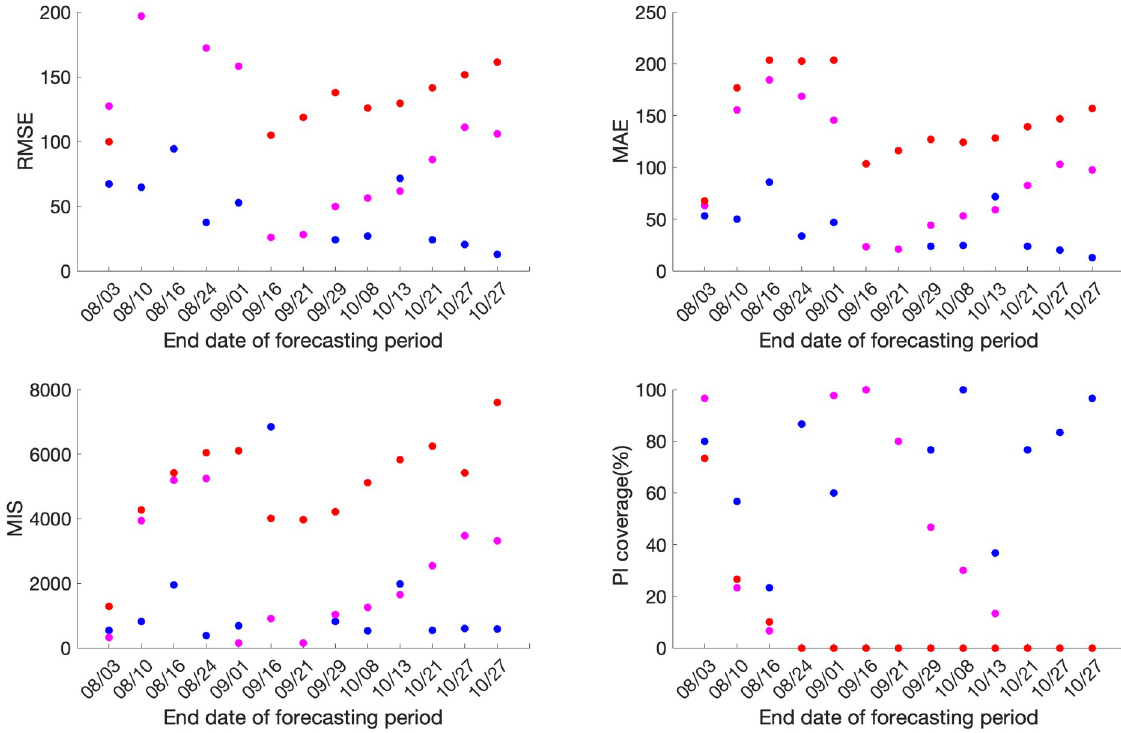
Fig 4. Forecasting period performance metrics for each of the thirteen sequential forecasting phases for GLM (magenta), Richards (red) and sub-epidemic (blue) model for Mexico. High 95% PI coverage and lower mean interval score (MIS), root mean square error (RMSE) and mean absolute error (MAE) indicate better